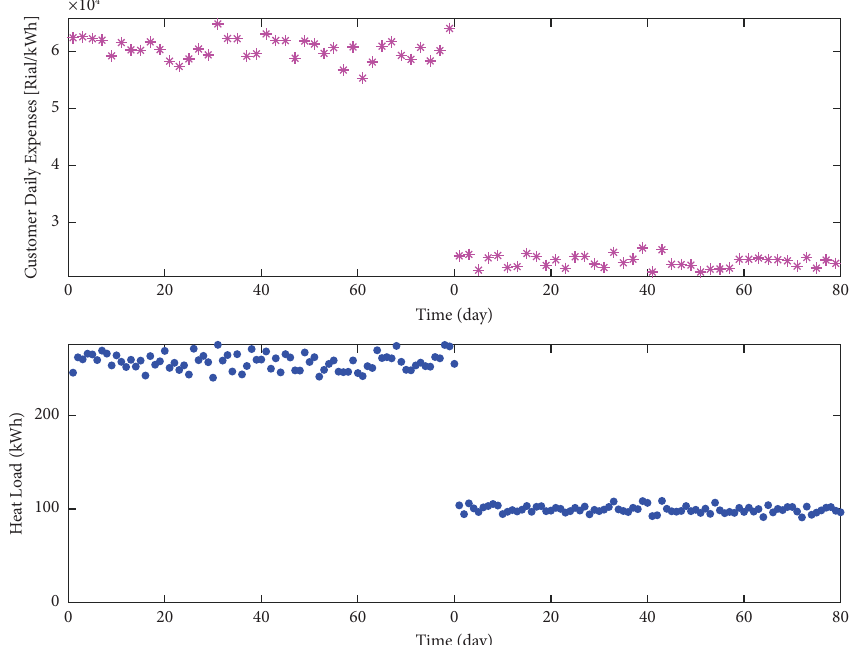
Figure 11: Average daily cost and consumption of the thermal consumer.